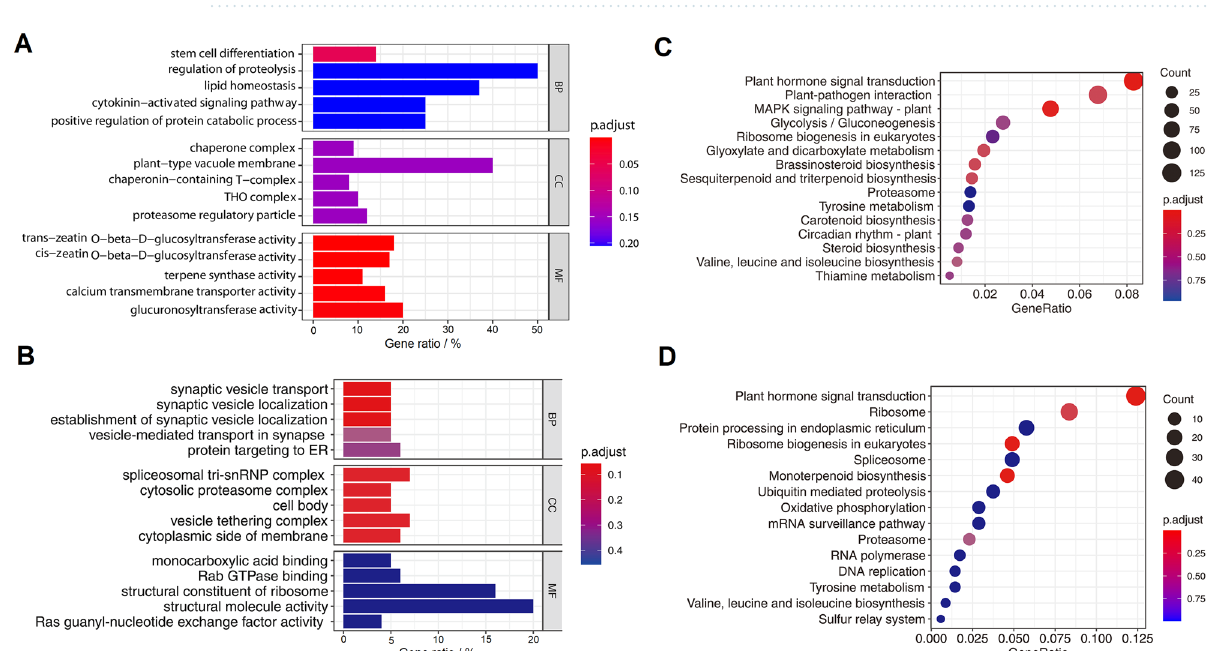
Figure 6. GO and KEGG annotation and enrichment of the putative targets of DELs. GO enrichment of cis- ( A ) and trans- ( B ) targets of DELs. BP, biological process. CC, cell component. MF, molecular function. KEGG enrichment of cis- ( C ) and trans- ( D ) targets of